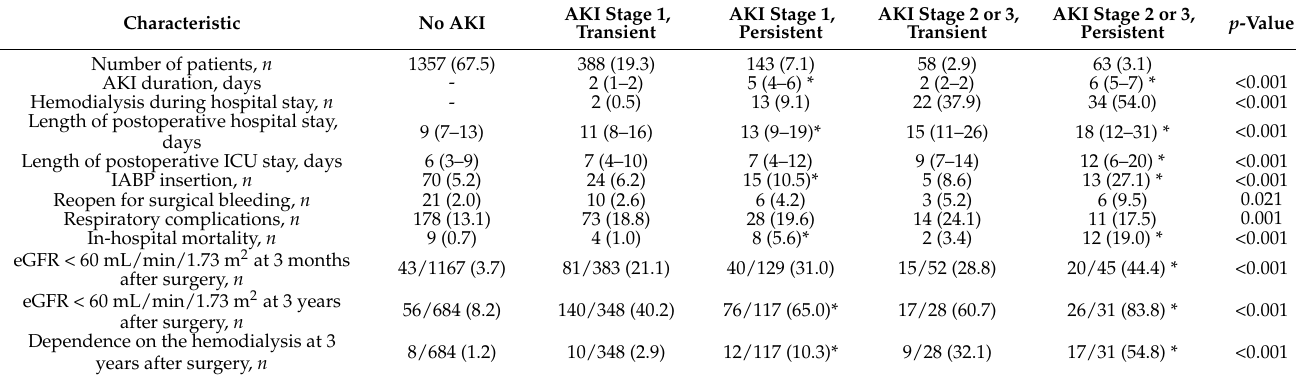
Table 3. Comparison of in-hospital and long-term outcomes across the stages of acute kidney